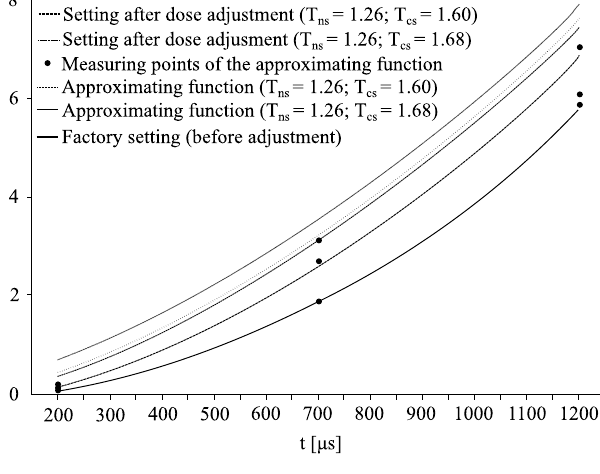
Fig. 6. Idle characteristics of the tested